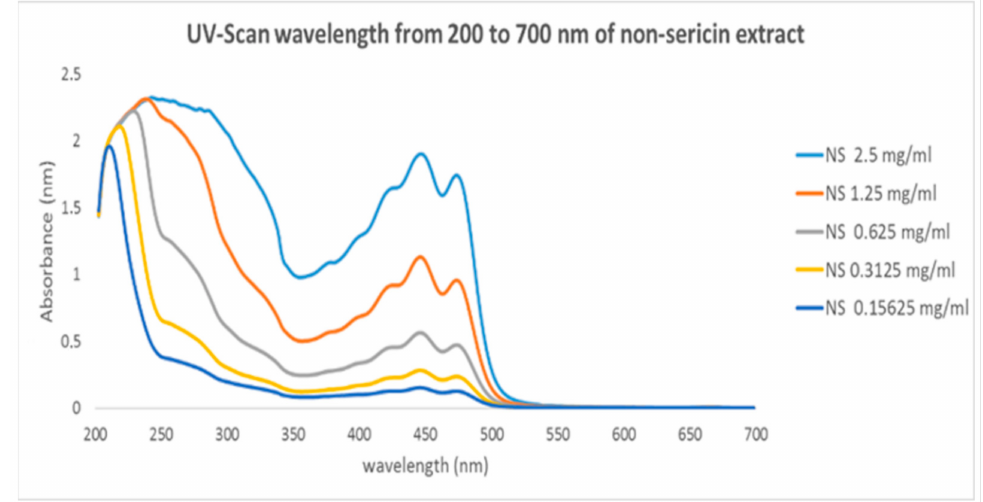
Figure 3. UV-visible spectra of non-sericin extracts at various concentrations in DMSO demonstrating spectra in a range of 200–700 nm.